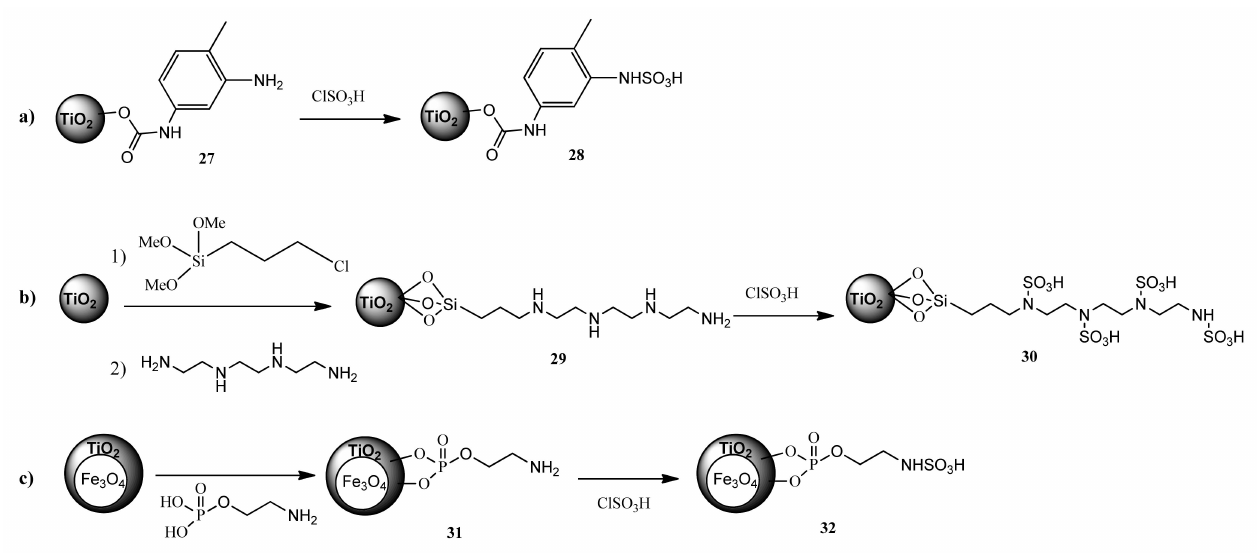
Figure 11. Sulfamic-functionalized titania-based materials: aromatic (approach ( a )), aliphatic (approach ( b )) and magnetic (approach ( c )) derivatives from refs